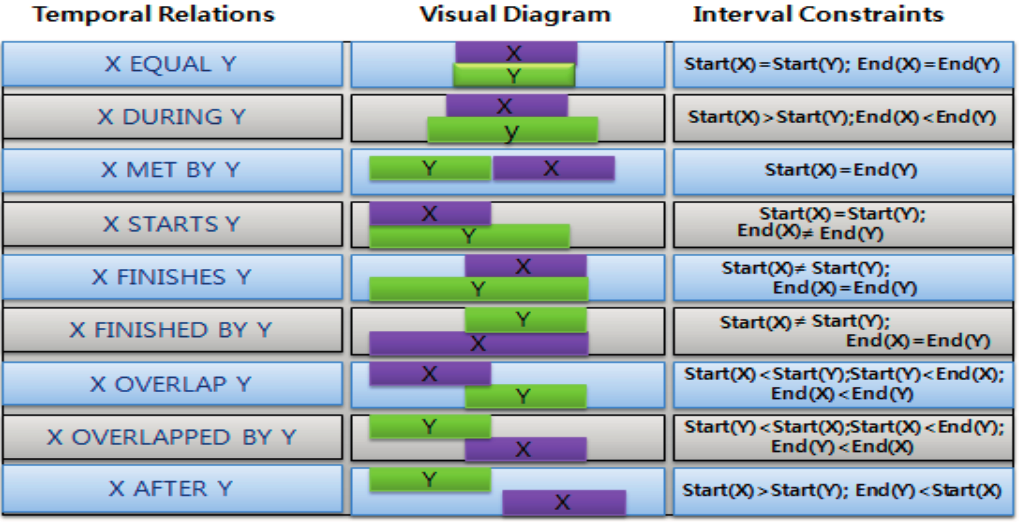
Figure 11. Temporal relations